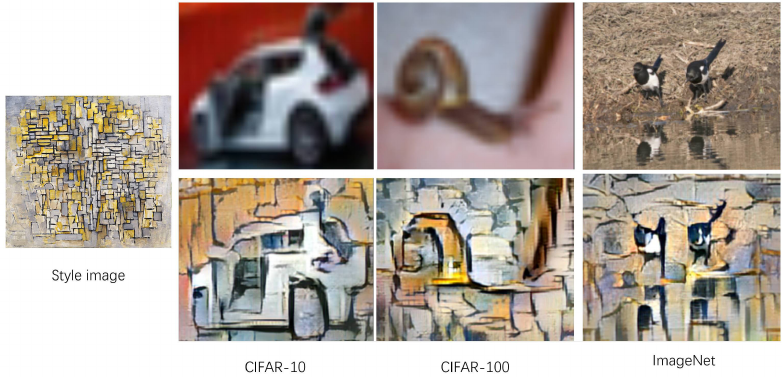
Figure 2. Stylized image examples on three dataset: CIFAR-10, CIFAR-100, and